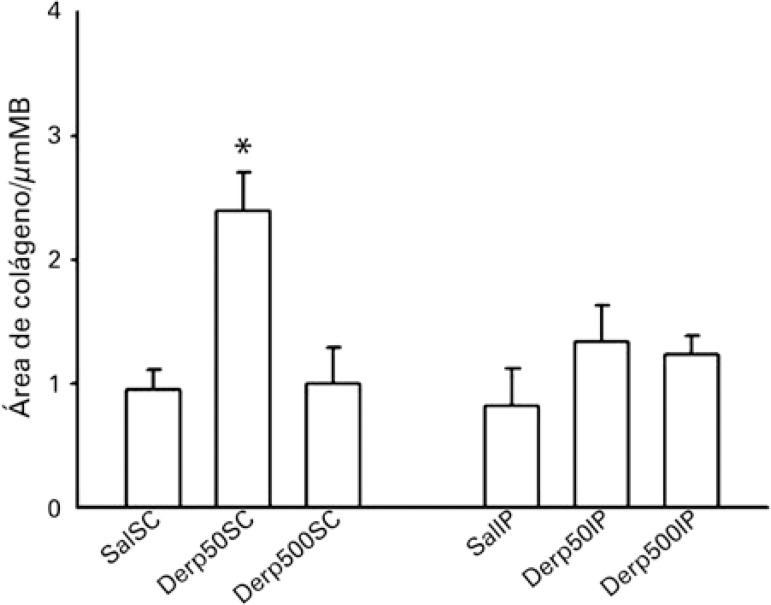
Avaliação do remodelamento das vias aéreas pela quantificação de fibras colágenas coradas por Picrosirius. A área do colágeno (média ± erro padrão) foi expressa em uma relação entre a área das fibras colágenas (em µm2) e o perímetro da via aérea (em µm2)